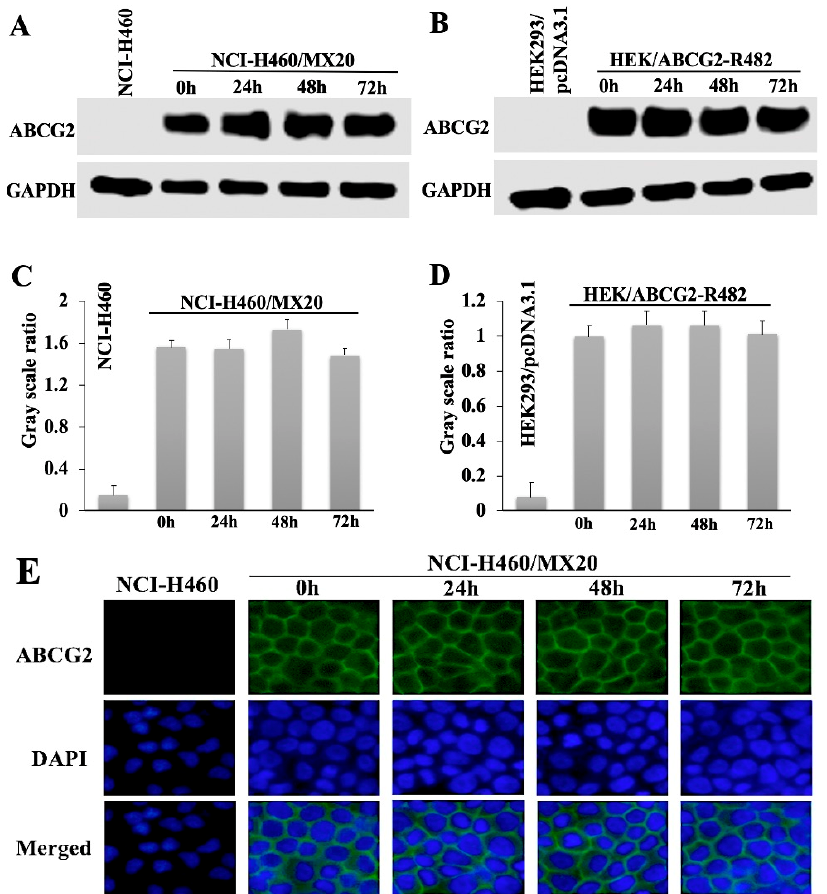
Figure 6. Effect of BMS-599626 on the protein expression and subcellular localization of ABCG2. Effect on the expression of ABCG2 protein after treatment with 300 nM BMS-599626 at different time points (0, 24, 48 and 72 h) in ( A ) NCI-H460/MX20 and ( B ) HEK/ABCG2-R482 cells. GAPDH was used as a loading control and equal amounts of protein were loaded for each sample. ( C , D ) Quantification of the protein expression was done by gray scale values. Error bars are representative of mean ± SD from 3 independent experiments. ( E ) ABCG2 protein expression in NCI-H460 and NCI-H460/MX20 cells after incubation with 300 nM BMS-599626 for different time periods (0, 24, 48 and 72 h). DAPI was used to counterstain the nuclei. Images have been modified by Photoshop software for merged comparison.